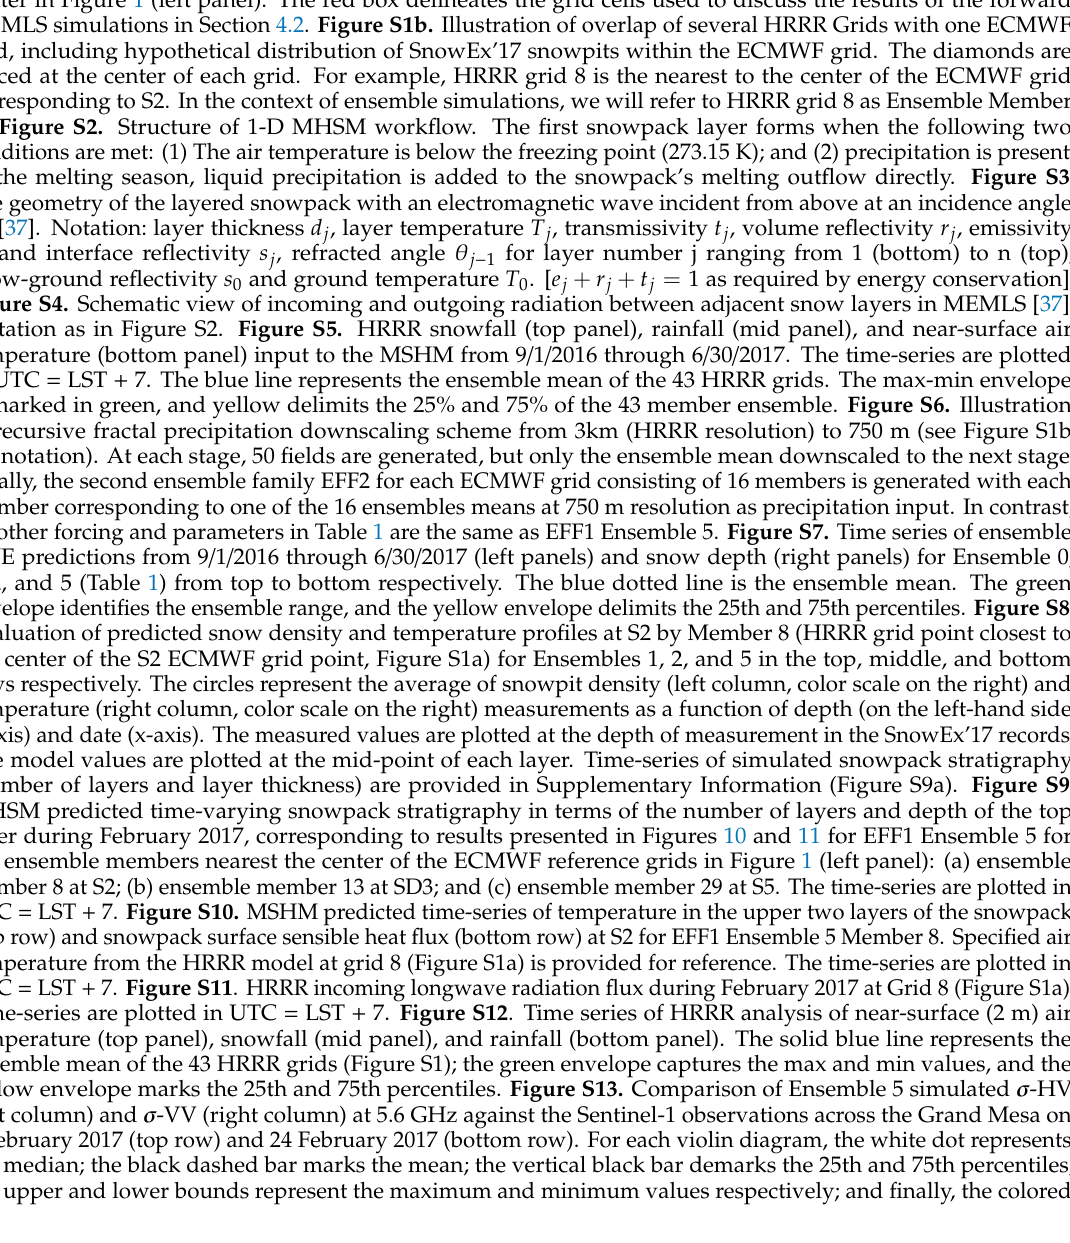
Figure S1a. Numbering order convention for HRRR grid cells in Figure 1 (right panel) corresponding to the ID numbers in Table S1. HRRR grid cells were selected based on their proximity to the ECMWF grid cells’ center in Figure 1 (left panel). The red box delineates the grid cells used to discuss the results of the forward MEMLS simulations in Section 4.2. Figure S1b. Illustration of overlap of several HRRR Grids with one ECMWF grid, including hypothetical distribution of SnowEx’17 snowpits within the ECMWF grid. The diamonds are placed at the center of each grid. For example, HRRR grid 8 is the nearest to the center of the ECMWF grid corresponding to S2. In the context of ensemble simulations, we will refer to HRRR grid 8 as Ensemble Member 8. Figure S2. Structure of 1-D MHSM workflow. The first snowpack layer forms when the following two conditions are met: (1) The air temperature is below the freezing point (273.15 K); and (2) precipitation is present. In the melting season, liquid precipitation is added to the snowpack’s melting outflow directly. Figure S3. The geometry of the layered snowpack with an electromagnetic wave incident from above at an incidence angle θ n [37]. Notation: layer thickness d j , layer temperature T j , transmissivity t j , volume reflectivity r j , emissivity e j , and interface reflectivity s j , refracted angle θ j − 1 for layer number j ranging from 1 (bottom) to n (top), snow-ground reflectivity s 0 and ground temperature T 0 . [ e j + r j + t j = 1 as required by energy conservation]. Figure S4. Schematic view of incoming and outgoing radiation between adjacent snow layers in MEMLS [37]. Notation as in Figure S2. Figure S5. HRRR snowfall (top panel), rainfall (mid panel), and near-surface air temperature (bottom panel) input to the MSHM from 9 / 1 / 2016 through 6 / 30 / 2017. The time-series are plotted in UTC = LST + 7. The blue line represents the ensemble mean of the 43 HRRR grids. The max-min envelope is marked in green, and yellow delimits the 25% and 75% of the 43 member ensemble. Figure S6. Illustration of recursive fractal precipitation downscaling scheme from 3km (HRRR resolution) to 750 m (see Figure S1b for notation). At each stage, 50 fields are generated, but only the ensemble mean downscaled to the next stage. Finally, the second ensemble family EFF2 for each ECMWF grid consisting of 16 members is generated with each member corresponding to one of the 16 ensembles means at 750 m resolution as precipitation input. In contrast, all other forcing and parameters in Table 1 are the same as EFF1 Ensemble 5. Figure S7. Time series of ensemble SWE predictions from 9 / 1 / 2016 through 6 / 30 / 2017 (left panels) and snow depth (right panels) for Ensemble 0, 1, 2, and 5 (Table 1) from top to bottom respectively. The blue dotted line is the ensemble mean. The green envelope identifies the ensemble range, and the yellow envelope delimits the 25th and 75th percentiles. Figure S8. Evaluation of predicted snow density and temperature profiles at S2 by Member 8 (HRRR grid point closest to the center of the S2 ECMWF grid point, Figure S1a) for Ensembles 1, 2, and 5 in the top, middle, and bottom rows respectively. The circles represent the average of snowpit density (left column, color scale on the right) and temperature (right column, color scale on the right) measurements as a function of depth (on the left-hand side y-axis) and date (x-axis). The measured values are plotted at the depth of measurement in the SnowEx’17 records. The model values are plotted at the mid-point of each layer. Time-series of simulated snowpack stratigraphy (number of layers and layer thickness) are provided in Supplementary Information (Figure S9a). Figure S9. MHSM predicted time-varying snowpack stratigraphy in terms of the number of layers and depth of the top layer during February 2017, corresponding to results presented in Figures 10 and 11 for EFF1 Ensemble 5 for the ensemble members nearest the center of the ECMWF reference grids in Figure 1 (left panel): (a) ensemble member 8 at S2; (b) ensemble member 13 at SD3; and (c) ensemble member 29 at S5. The time-series are plotted in UTC = LST + 7. Figure S10. MSHM predicted time-series of temperature in the upper two layers of the snowpack (top row) and snowpack surface sensible heat flux (bottom row) at S2 for EFF1 Ensemble 5 Member 8. Specified air temperature from the HRRR model at grid 8 (Figure S1a) is provided for reference. The time-series are plotted in UTC = LST + 7. Figure S11 . HRRR incoming longwave radiation flux during February 2017 at Grid 8 (Figure S1a). Time-series are plotted in UTC = LST + 7. Figure S12 . Time series of HRRR analysis of near-surface (2 m) air temperature (top panel), snowfall (mid panel), and rainfall (bottom panel). The solid blue line represents the ensemble mean of the 43 HRRR grids (Figure S1); the green envelope captures the max and min values, and the yellow envelope marks the 25th and 75th percentiles. Figure S13. Comparison of Ensemble 5 simulated σ -HV (left column) and σ -VV (right column) at 5.6 GHz against the Sentinel-1 observations across the Grand Mesa on 7 February 2017 (top row) and 24 February 2017 (bottom row). For each violin diagram, the white dot represents the median; the black dashed bar marks the mean; the vertical black bar demarks the 25th and 75th percentiles; the upper and lower bounds represent the maximum and minimum values respectively; and finally, the